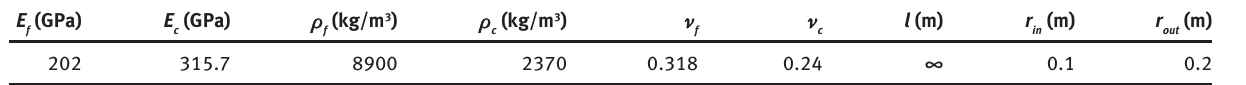
Table 1 Geometry and material properties of the FG cylinder investigated by Shariyat et al. [19]